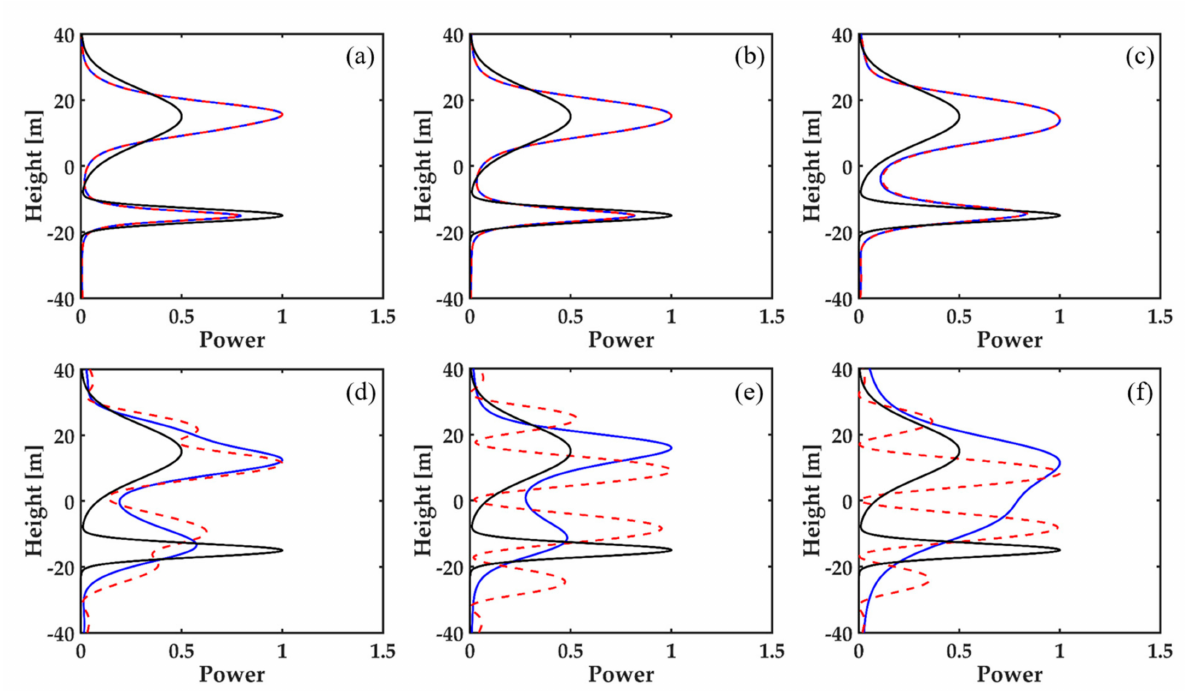
Figure 2. Reconstructed reflectivity profiles by the RIAA and IAA methods with different tomographic apertures in the first scattering scenario: ( a ) 30 m; ( b ) 25 m; ( c ) 20 m; ( d ) 15 m; ( e ) 10 m; ( f ) 5 m. The black solid lines are the true simulated reflectivity profiles. The blue solid lines are the reconstructed reflectivity profiles of RIAA. The red dotted lines are the reconstructed reflectivity profiles of IAA.